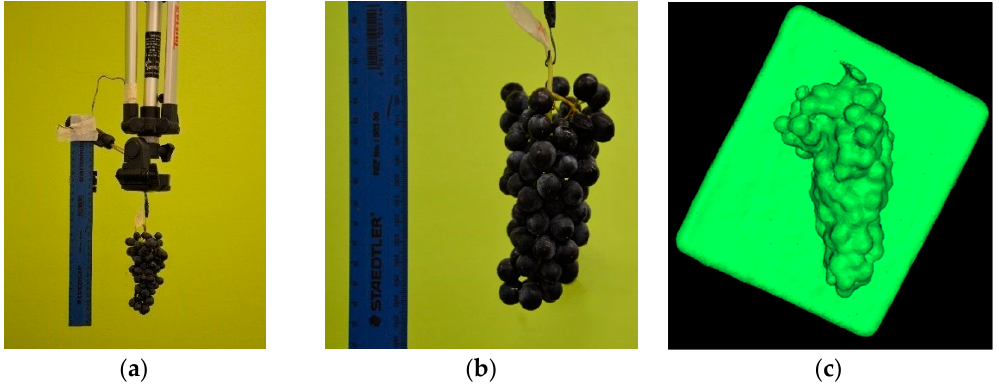
Figure 3. Data acquisition under laboratory conditions. ( a ) Experimental setup for image capture; ( b ) RGB image of an individual bunch with a ruler for reference length; and ( c ) RGB-D (Kinect mesh) of an individual